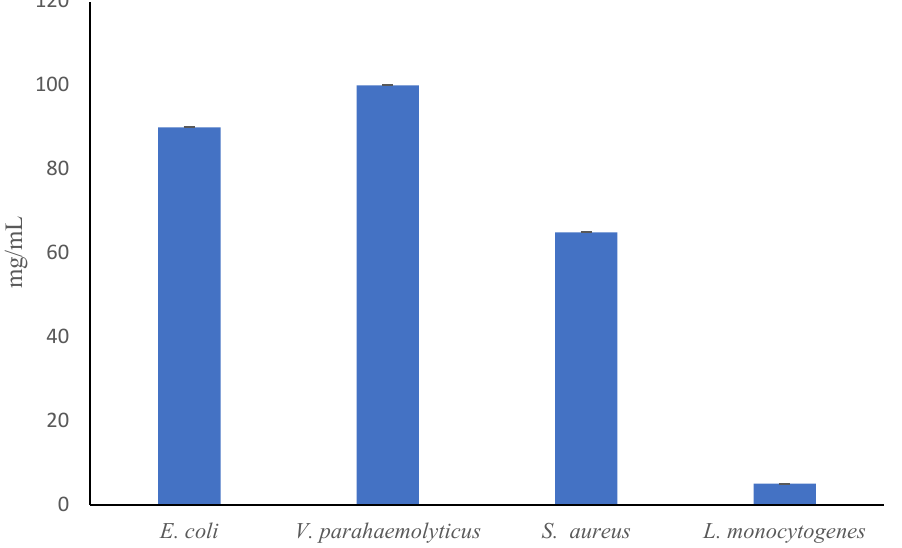
Figure 6. Minimum inhibitory concentration (MIC) of poly lactic acid (PLA) film containing anise essential oil against four food-borne pathogens.